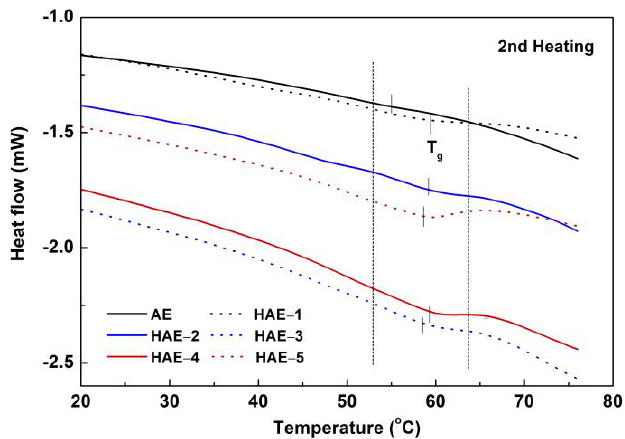
Figure 8. Differential scanning calorimetry thermograms of AE and HAEs at 2nd heating. Table 4. Results of hardening temperature and glass transition temperature (T g ) of AE and HAEs at 1st and 2nd